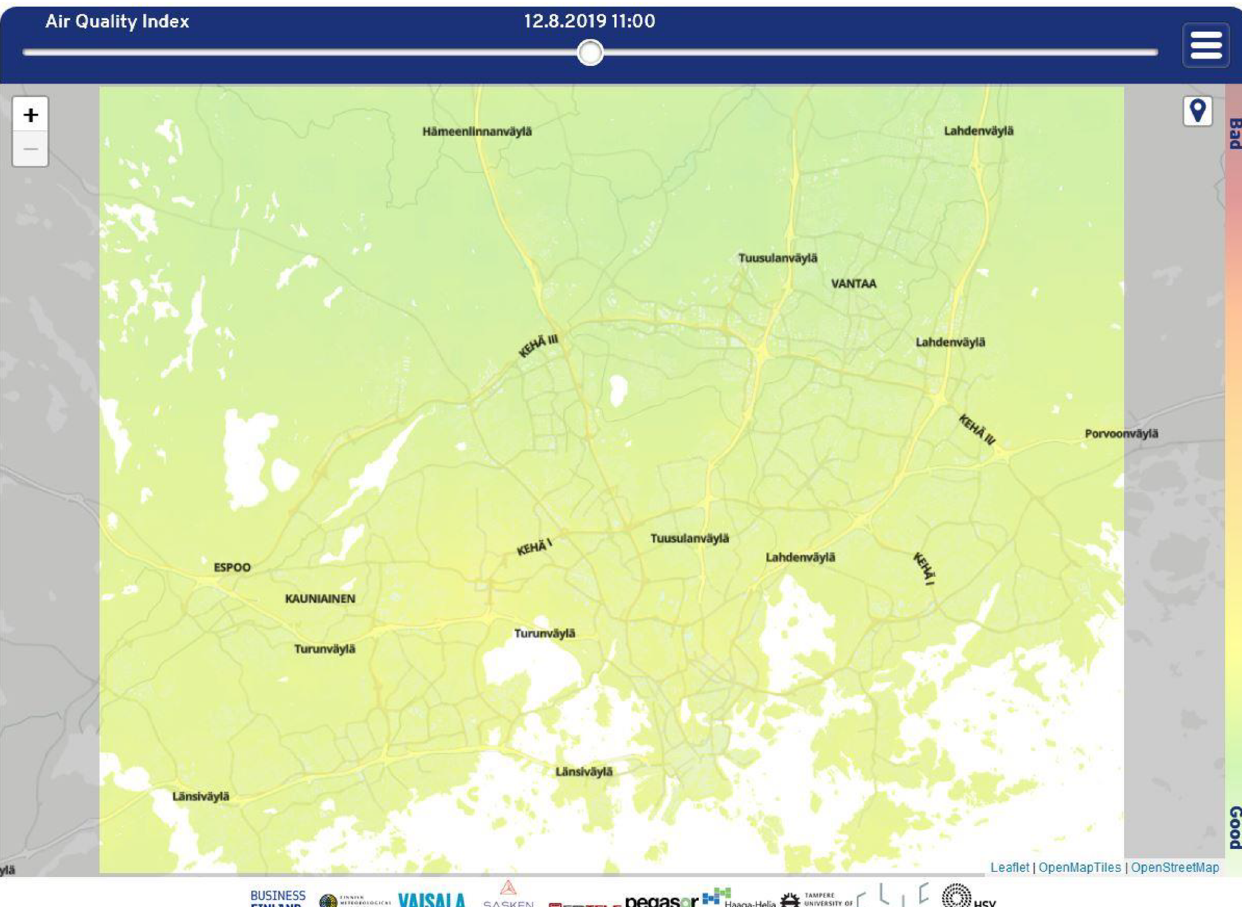
Figure 6. Air quality index forecast for the Helsinki area © OpenStreetMap contributors 2019, distributed under a Creative Commons BY-SA